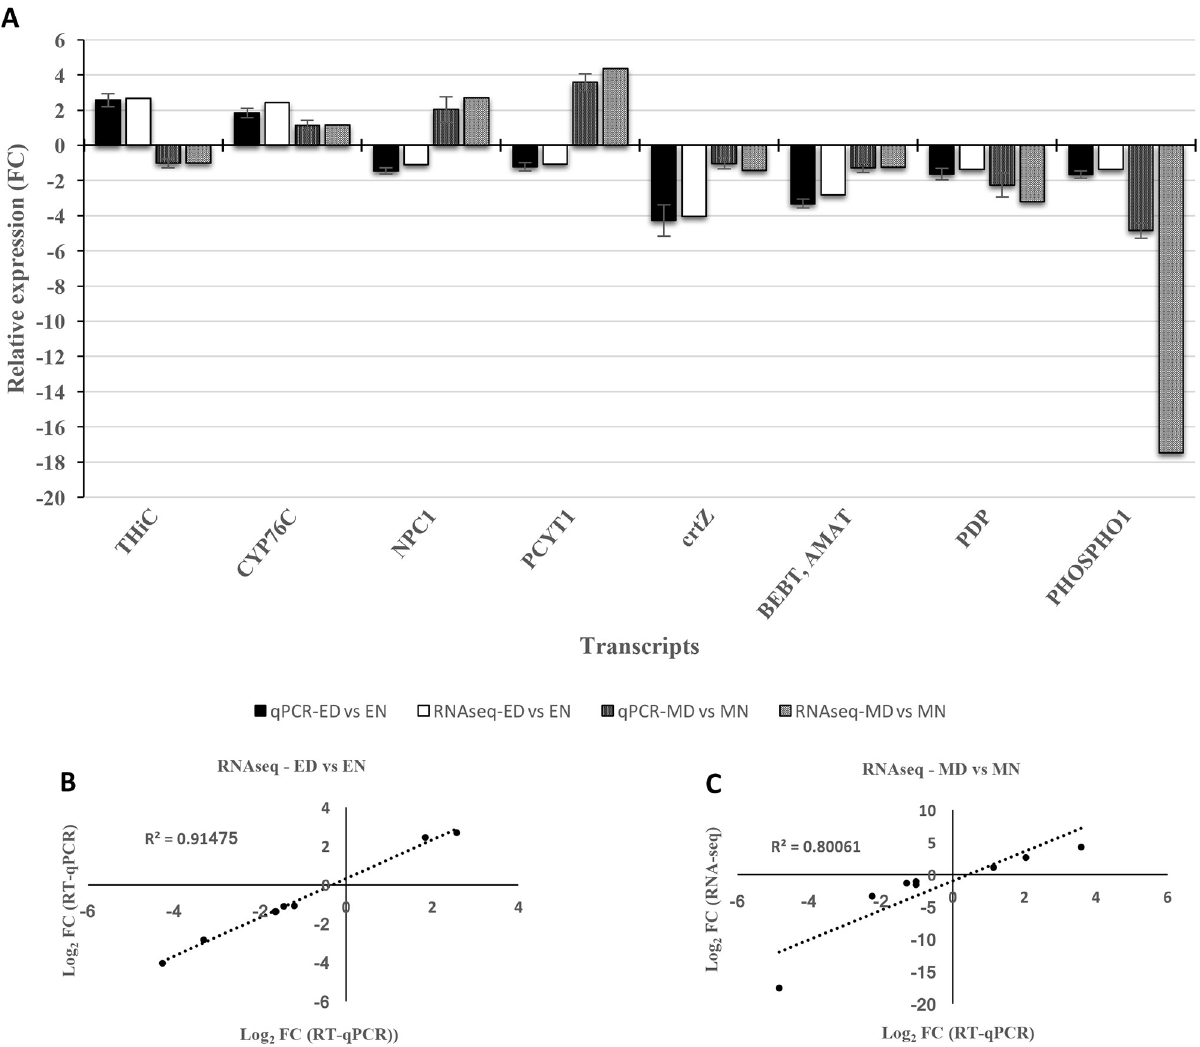
Fig 6. Expression patterns of 8 selected genes in “L-82” and “Marvdasht” in contrasting water regimes determined by RNA-Seq and qPCR. RNA-Seq values represent the ratio of the expression level in drought treated genotypes to the expression level of their related controls . For qPCR, the data are relative expression ± SD from three independent replicates (a). The qPCR primers for each contig are listed in additional file 1. Linear regression containing the RNA-Seq log 2 value and the RT-qPCR validation date, for drought tolerance (b) and drought sensitive (b) genotypes. ED, L- 82 under drought and EN, L-82 under normal conditions. MD, Marvdasht under drought and MN, Marvdasht under normal